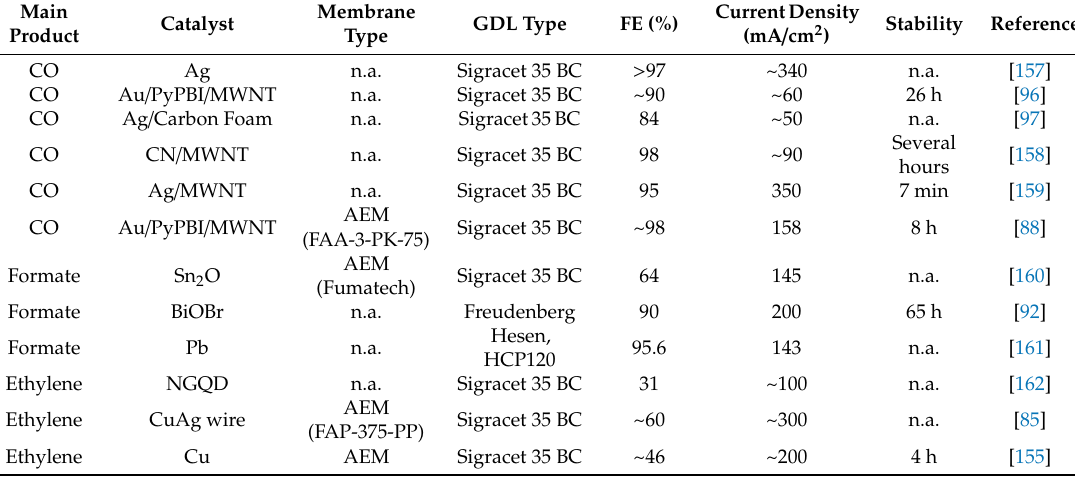
Table 3. A list of CO 2 conversion performance using microfluidic electrolysers. AEM: anion-exchange membrane, ~: